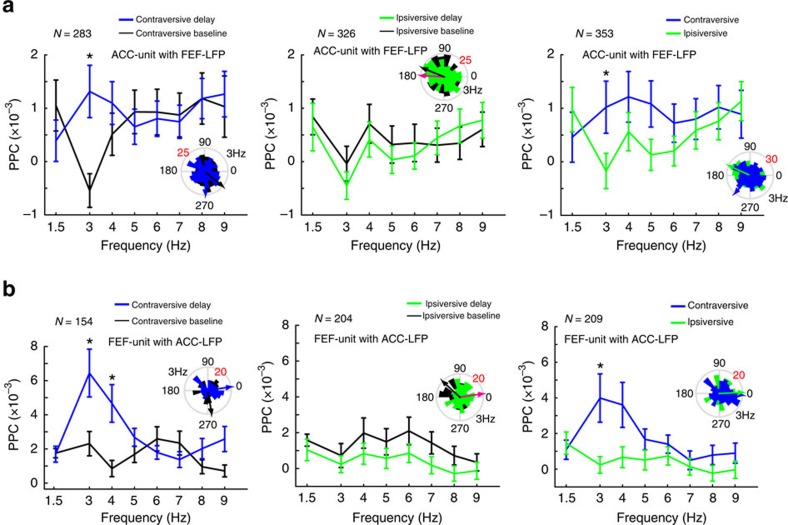
Pairwise phase consistencies (PPCs) across delta and theta band.(a) PPC spike-field coherence spectrum of the population of the ACC-unit with FEF-LFP pairs across the delta and theta frequency range. Comparison between baseline and delay of contraversive saccades (left), comparison between baseline and delay of ipsiversive saccades (middle), and comparison between the contra- and ipsiversive saccades in the delay period (right). (b) PPC spike-field coherence spectrum of the population of the FEF-unit with ACC-LFP pairs across the delta and theta frequency range. Comparison between baseline and delay of contraversive saccades (left), comparison between baseline and delay of ipsiversive saccades (middle), and comparison between the contra- and ipsiversive saccades in the delay period (right). It should be noted that the same significant differences between ipsi- and contraversive trials were seen even after we compared the contra- versus ipsiversive conditions using a permutation test as described in the Methods section. Error bars denote s.e.m. in all panels. *P<0.05, paired t-test. The rose plots on the side of each graph show the histogram of the coupling angles of the population of the ACC/FEF units.